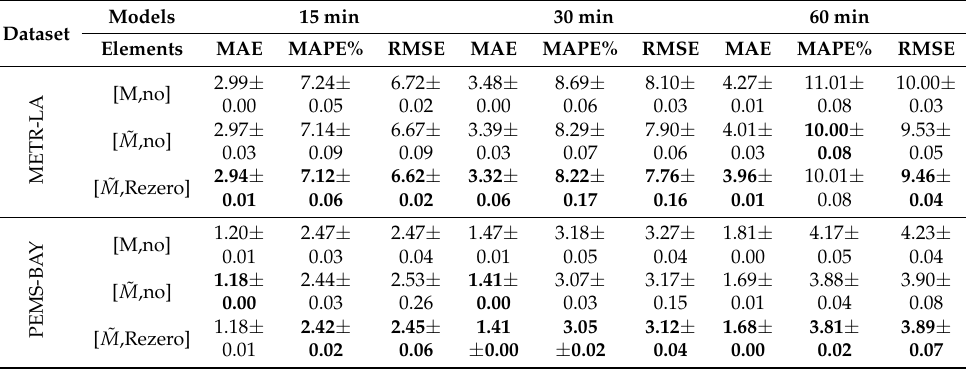
(cid:2) ˜ (cid:3) M , ReZero . We retrained each model five